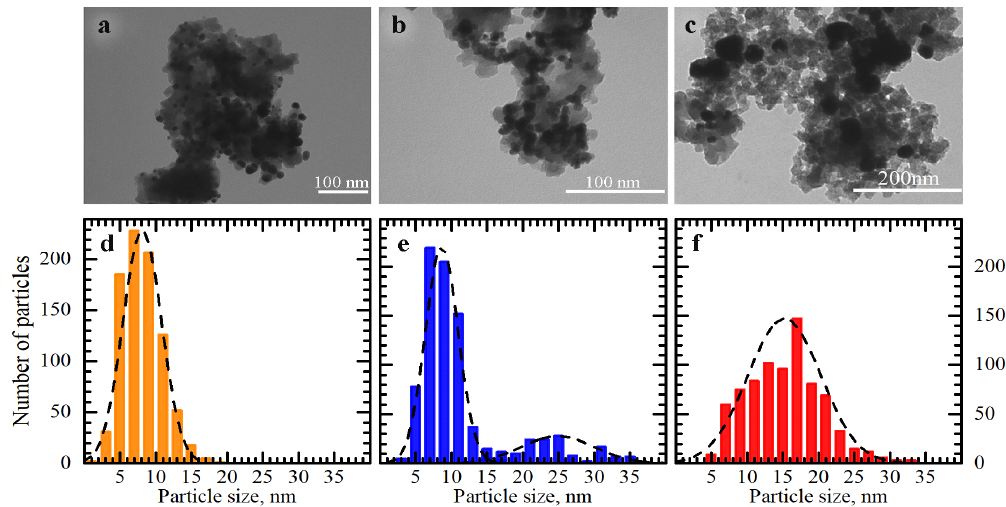
Figure 1. Representative TEM micrographs with corresponding particle size distributions for Pd/SiO 2 samples reduced by NaBH 4 : ( a ) sample Pd-NPs NaBH ₄ ; reduced by hydrazine: samples ( b ) Pd-NPs hydrazine and ( c ) Pd-NPs ammonia,hydrazine , with corresponding size distributions in parts ( d – f ). NP: nanoparticle.